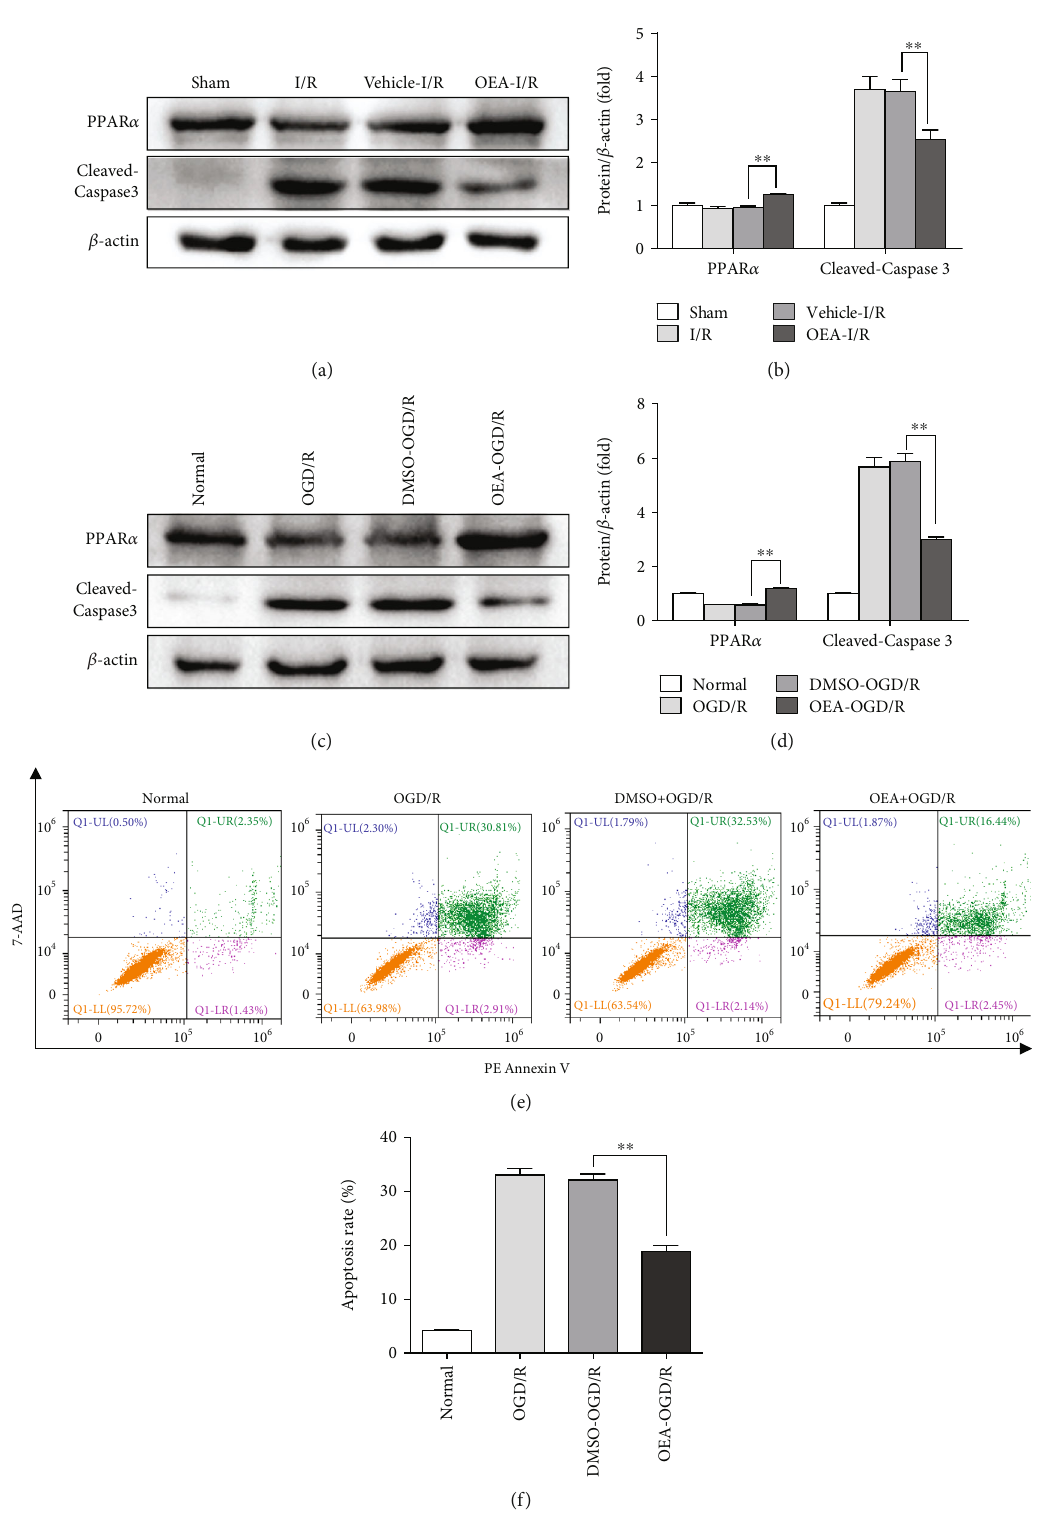
Figure 3: OEA activates PPAR α to ameliorate cell apoptosis. OEA treatment of HepG2 cells (20 μ M) was conducted for 1h before OGD/R. (a and b) Western blotting analysis of PPAR α and cleaved-Caspase3 after liver I/R injury. (c and d) Western blotting analysis of PPAR α and cleaved-Caspase3 expression in OGD/R-treated HepG2 cells. (e) The apoptosis from indicated groups was detected by fl ow cytometry. (f) Data are based on three independent assays ( n = 3 ). ∗∗ p < 0 : 01 and ∗ p < 0 : 05